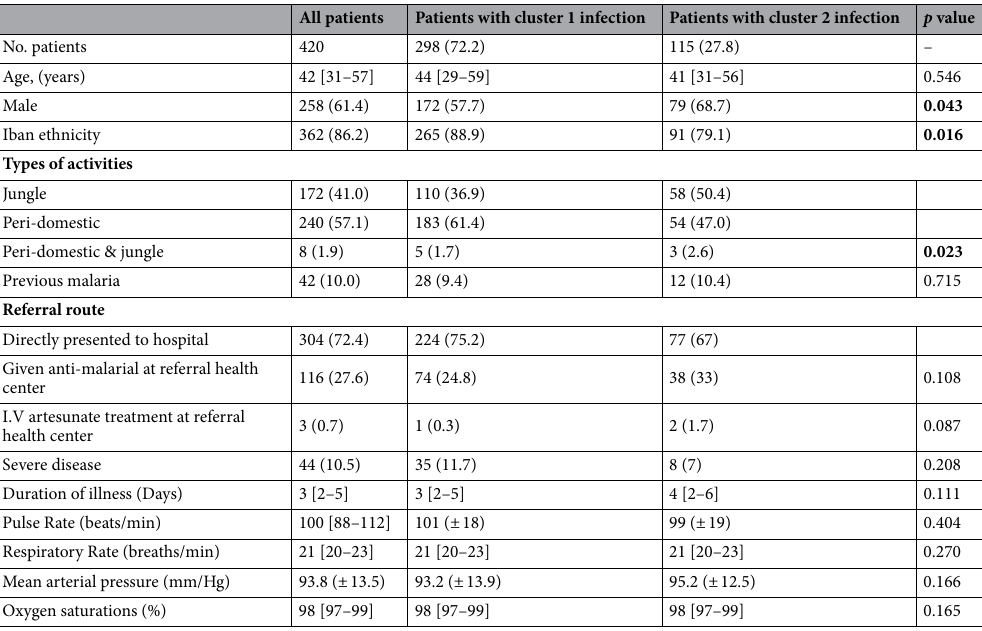
Table 1. Demographics and clinical presentation of P. knowlesi . Data are presented as no. (%), mean (± SD) or median [IQR]. p value < 0.05 are in bold. Adjusted Fisher’s exact from pairwise Bonferroni correction remained significant ( p = 0.039) between jungle and peri-domestic